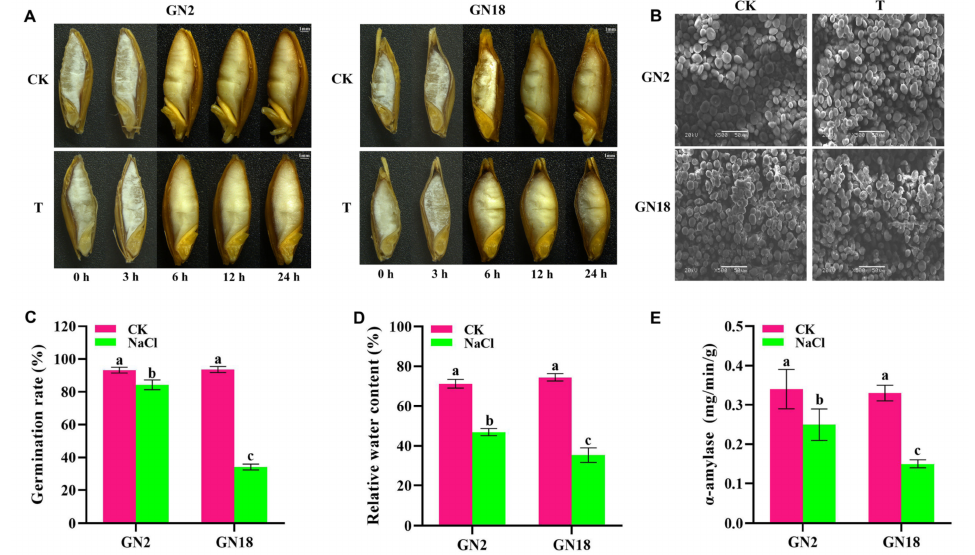
Figure 1. Morphological, ultrastructural and physiological parameter changes in the salt-tolerant barley cultivar GN2 and salt-sensitive barley cultivar GN18 during seed germination under salt stress. ( A ) Seed morphology images of seed germination from five periods in different treatment groups. ( B ) SEM images at 24 h of seed germination. ( C ) Seed germination rate. ( D ) Relative water content. ( E ) α -Amylase. Data are means three replicates ( n = 3) ± standard deviation (SD). Different letters indicate significant difference at p < 0.05 as determined by one-way ANOVA test. CK, water-treated seeds; T, 200 mM salt solution-treated seeds; NaCl, 200 mM salt solution-treated